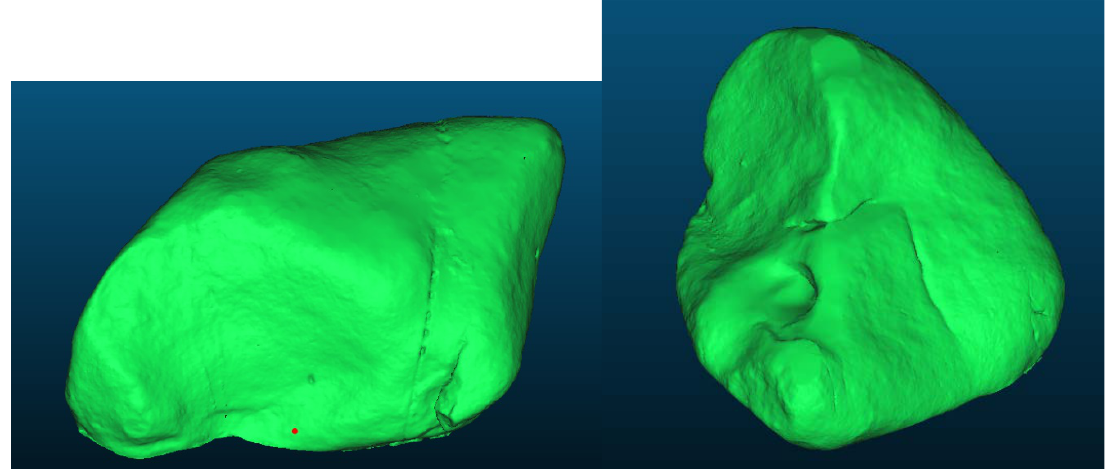
Figure 5. Reference models gained from TLS (Boulder No.1 – left, boulder No.2 – right).